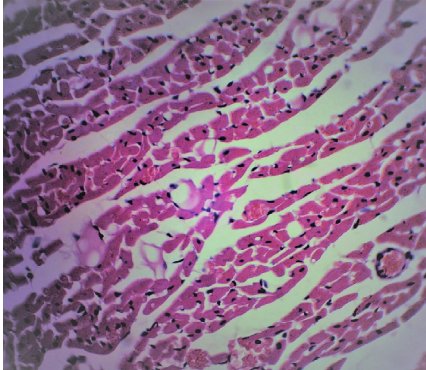
Figure 6: A photomicrograph of a cross-sectional representative of a doxorubicin-intoxicated rat heart treated with 20mg/kg/day vitamin C showing mild congestion and scattered myocyte necrosis ( × 400 magnification, hematoxylin-eosin